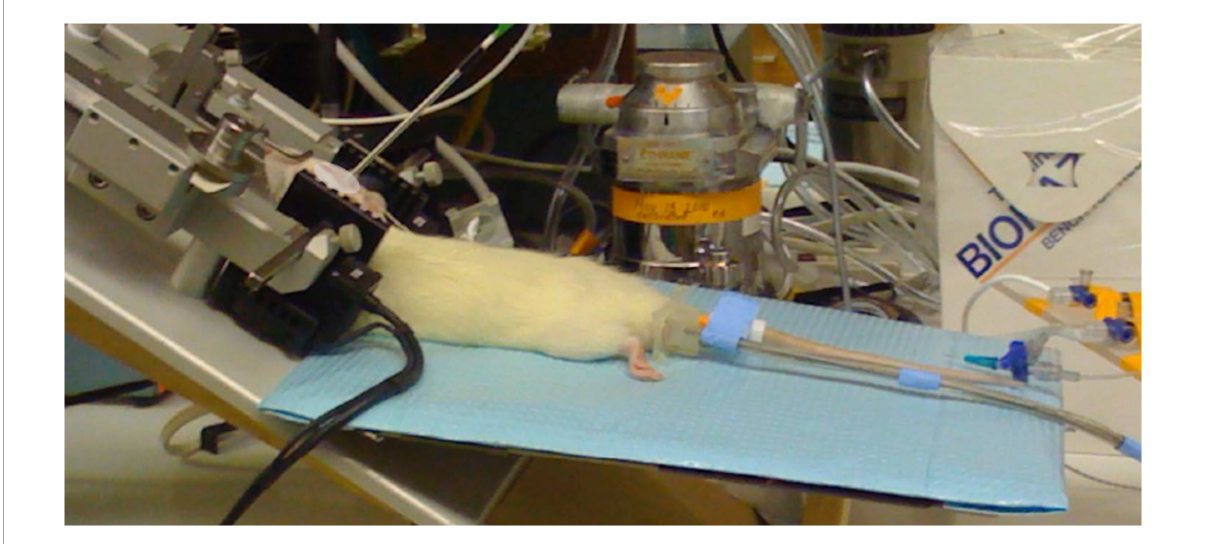
FIGURE2 Caloric ear bars in place, laser Doppler probe affixed; head flexed upward by 30 degrees, support pad tilted slightly upward.